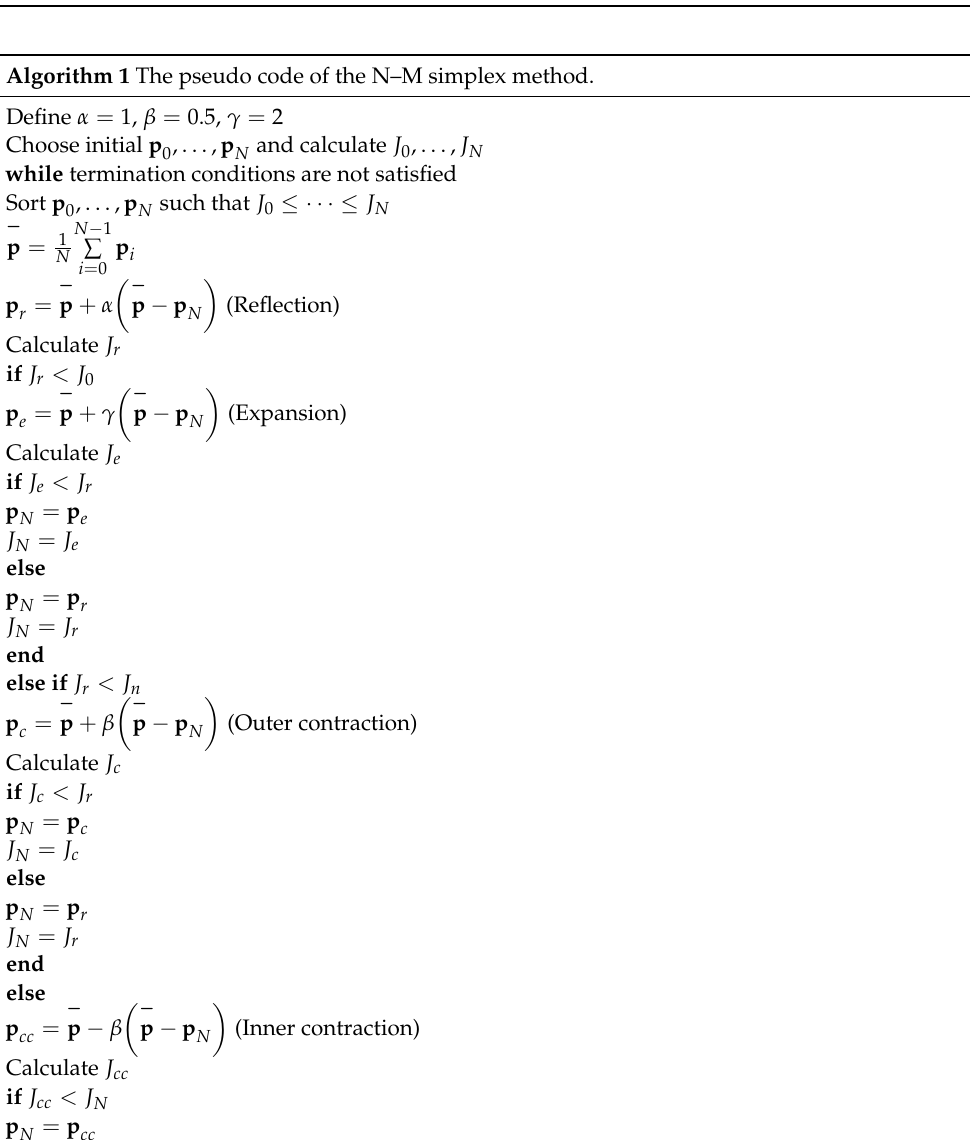
Algorithm 1 The pseudo code of the N–M simplex